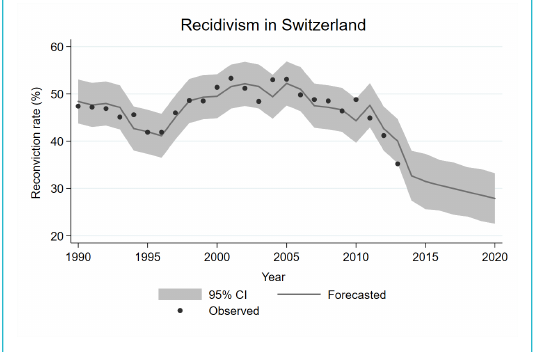
Figure 2: Observed and forecasted reconviction rates over time in Switzerland.